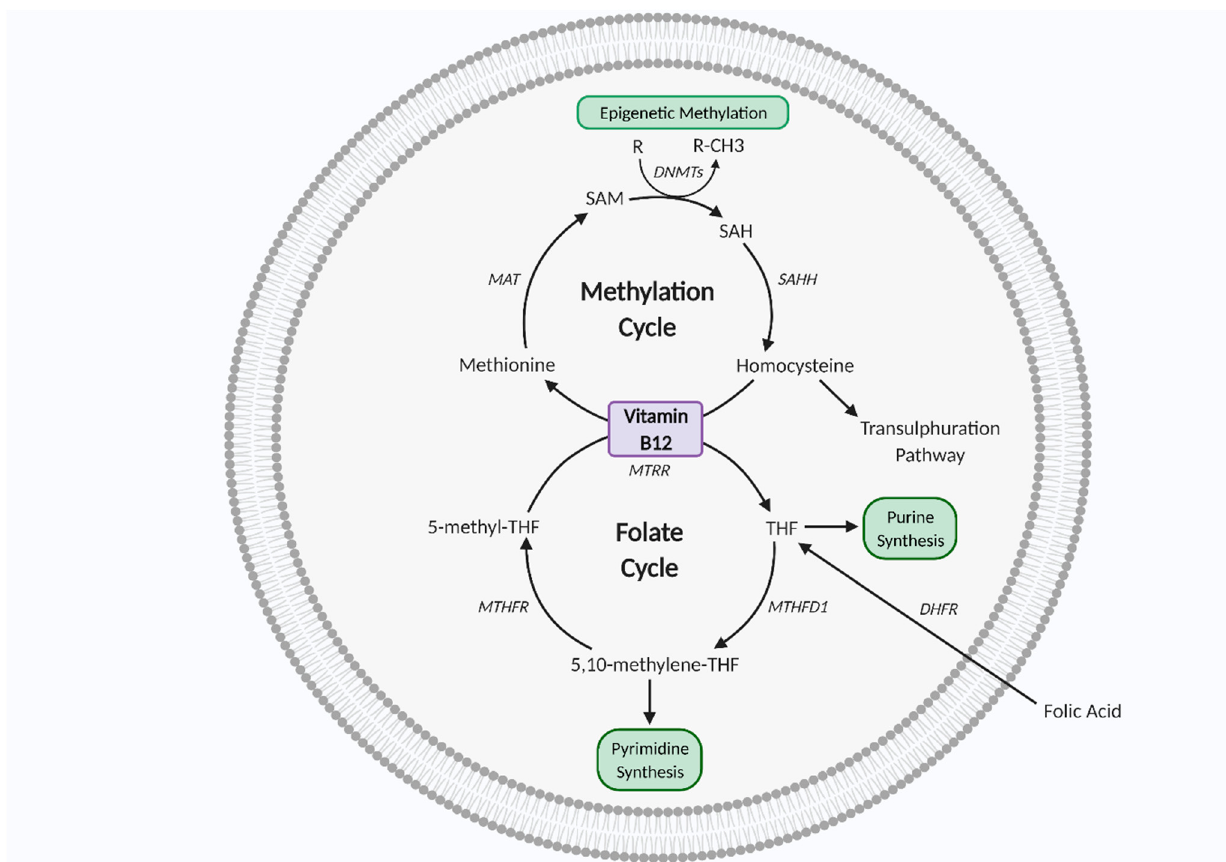
Figure 2. One carbon metabolism. Vitamin B 12 and folate are co-factors of the methylation and folate cycles which interlink to complete the one carbon metabolism, essential for cell proliferation, differentiation, and growth. DHFR, dihydrofolate reductase; DNMTs, DNA methyltransferase; MAT, methionine adenosyltransferase; MTHFD1, methylenetetrahydrofolate dehydrogenase 1; MTHFR, methylenetetrahydrofolate reductase; MTRR, methyltransferase reductase; SAH, S adenosyl L homocysteine; SAHH, adenosylhomocysteinase; SAM, S-adenosyl methionine; THF, tetrahydrofolate. Figure created using Biorender.com.